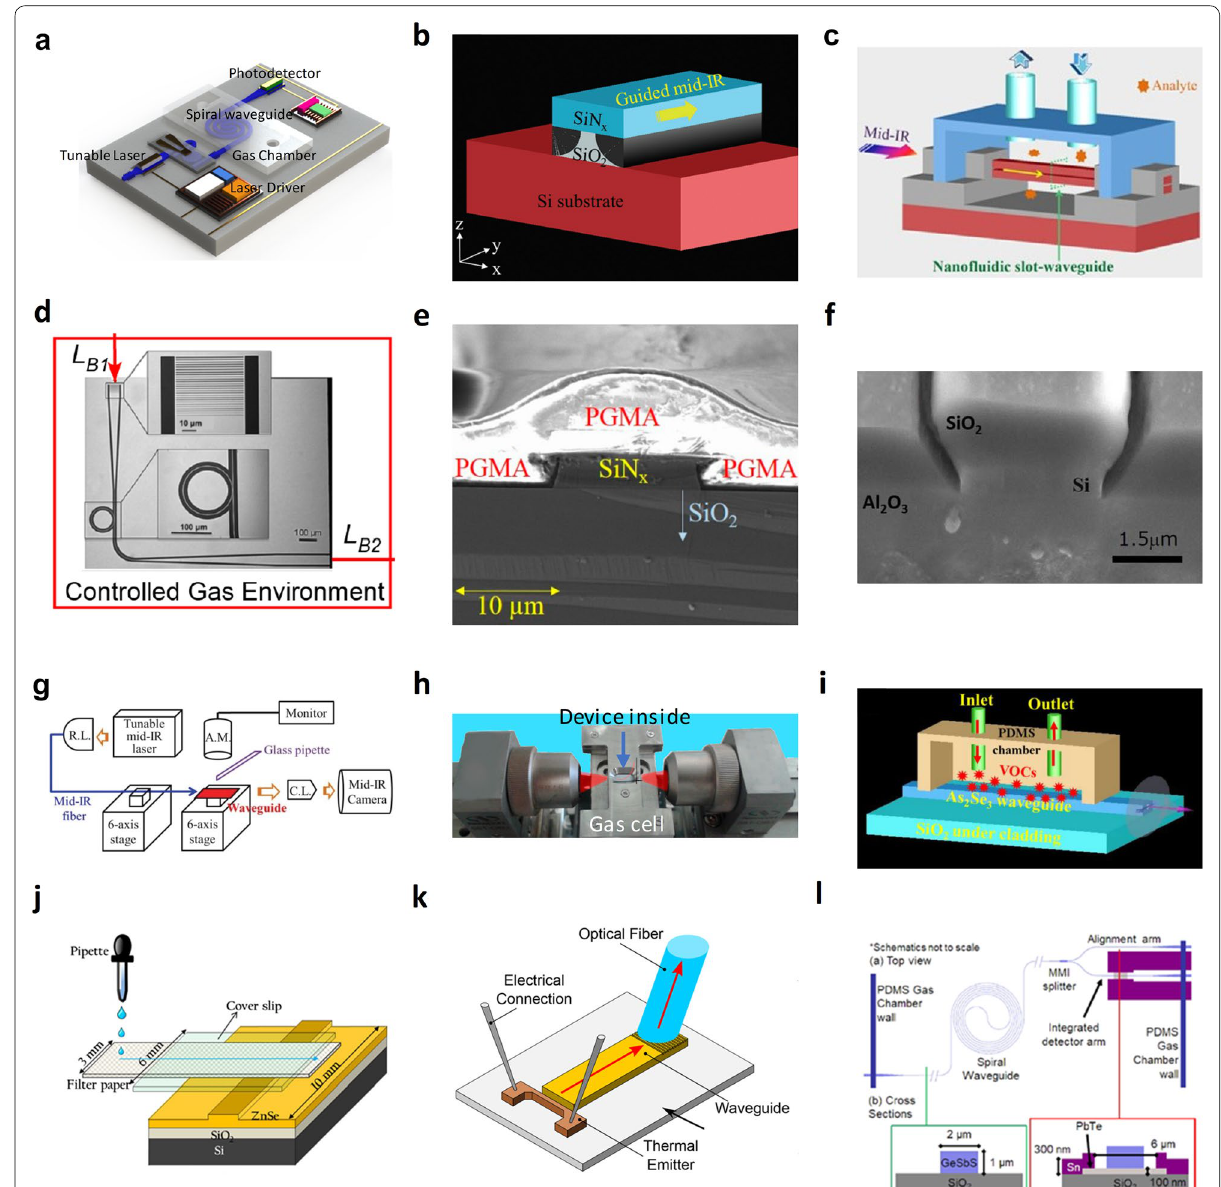
Fig. 7 Device configurations and system integration of MIR guided-wave nanophotonic biochemical sensors. a Spiral waveguide